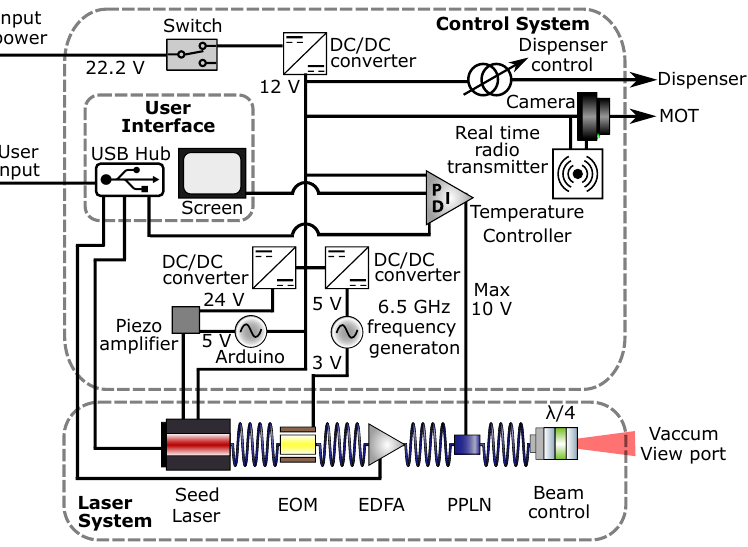
Figure 2. A block diagram of the electrical and optical components in the payload. The 22.2 Volt line from the batteries is fed into the payload; this is then converted into the required powers for each component. The output light from a seed laser (1560 nm) is modulated by an EOM driven by an oscillator to generate frequency sidebands, this is then amplified by a 1 W EDFA before being frequency doubled via second harmonic generation using a PPLN waveguide. The output of the fibre passes through two beam expanders and a quarter waveplate. This light is then input into the MOT vacuum chamber. A user interface allows for users to communicate with various sub-components and monitor the status of the payload. While in flight, the camera feed is broadcast in real time to the operator on the ground.